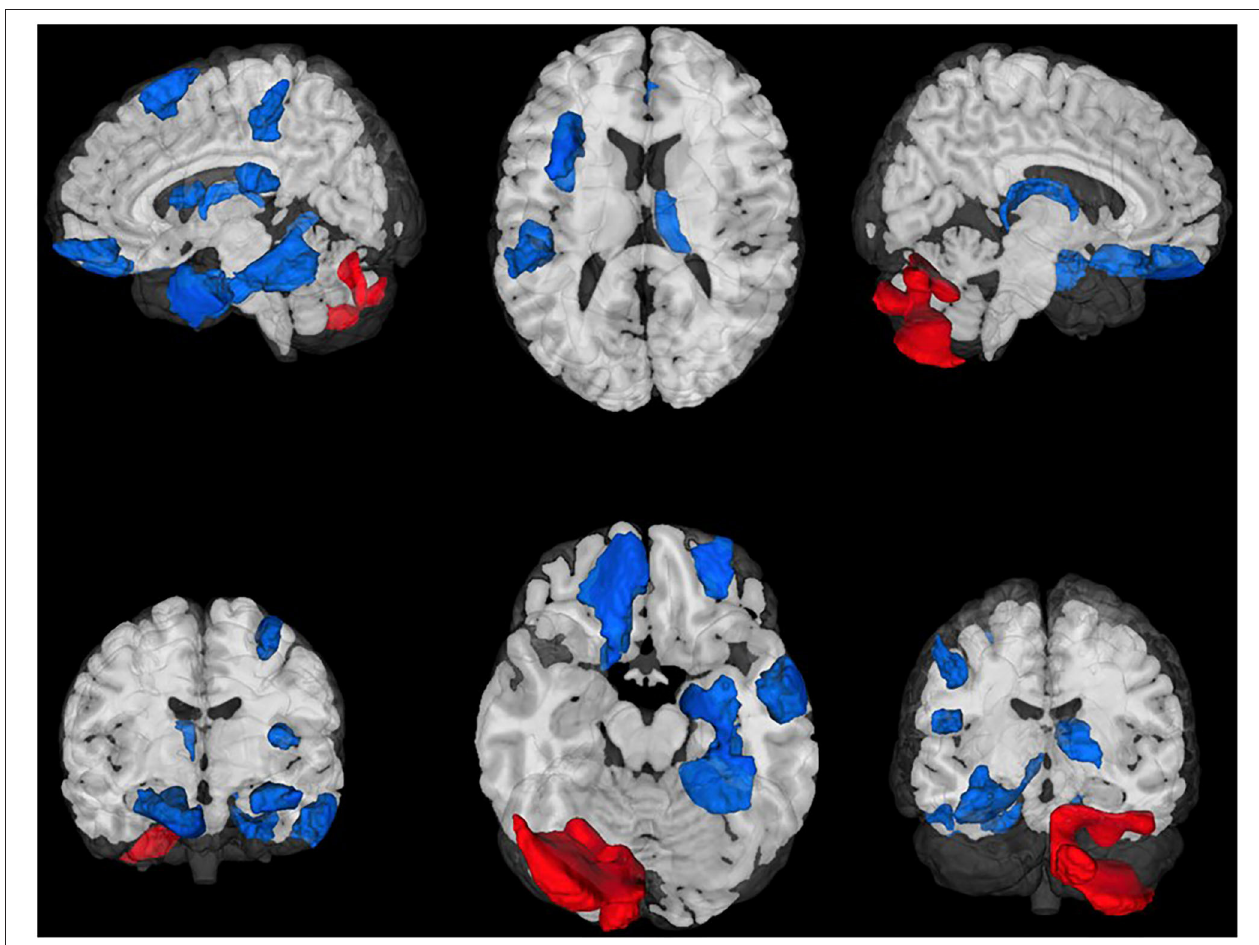
FIGURE 1 | Regions of interest (ROIs) exhibiting moderate-to-large baseline adjusted differences in gray matter volume (GMV). Greater GMV was observed following blue light treatment (ROIs in blue) in 15 cortical and subcortical ROIs. Greater GMV was observed following amber light (red ROIs) in two cerebellar regions. All ROIs were false discovery rate corrected p < 0.05. Top Left: Lateral left view, Top Middle: Superior view; Top Right, Lateral right view. Bottom Left, anterior view; Bottom Middle: Inferior view; Bottom Right: Posterior